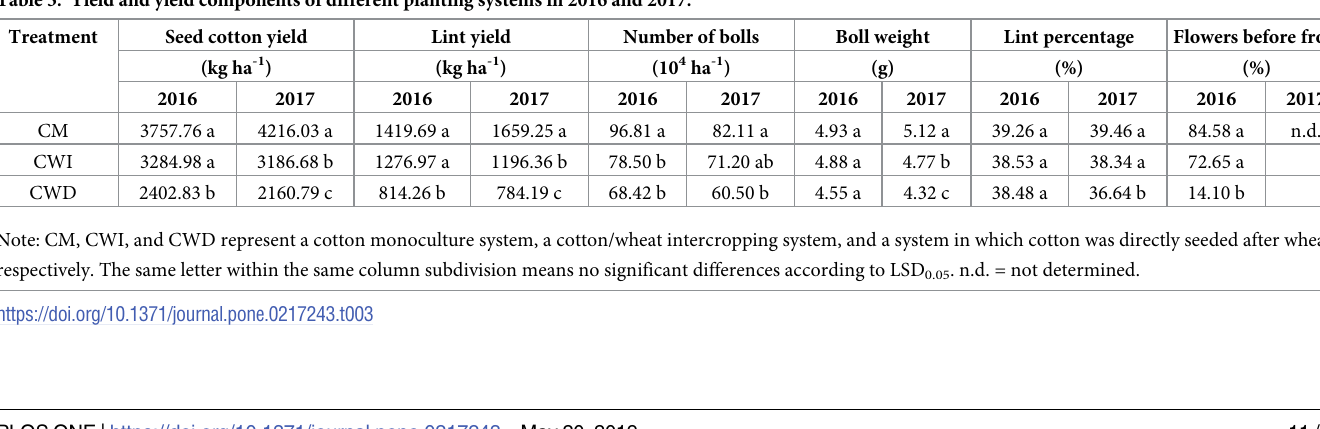
Table 3. Yield and yield components of different planting systems in 2016 and